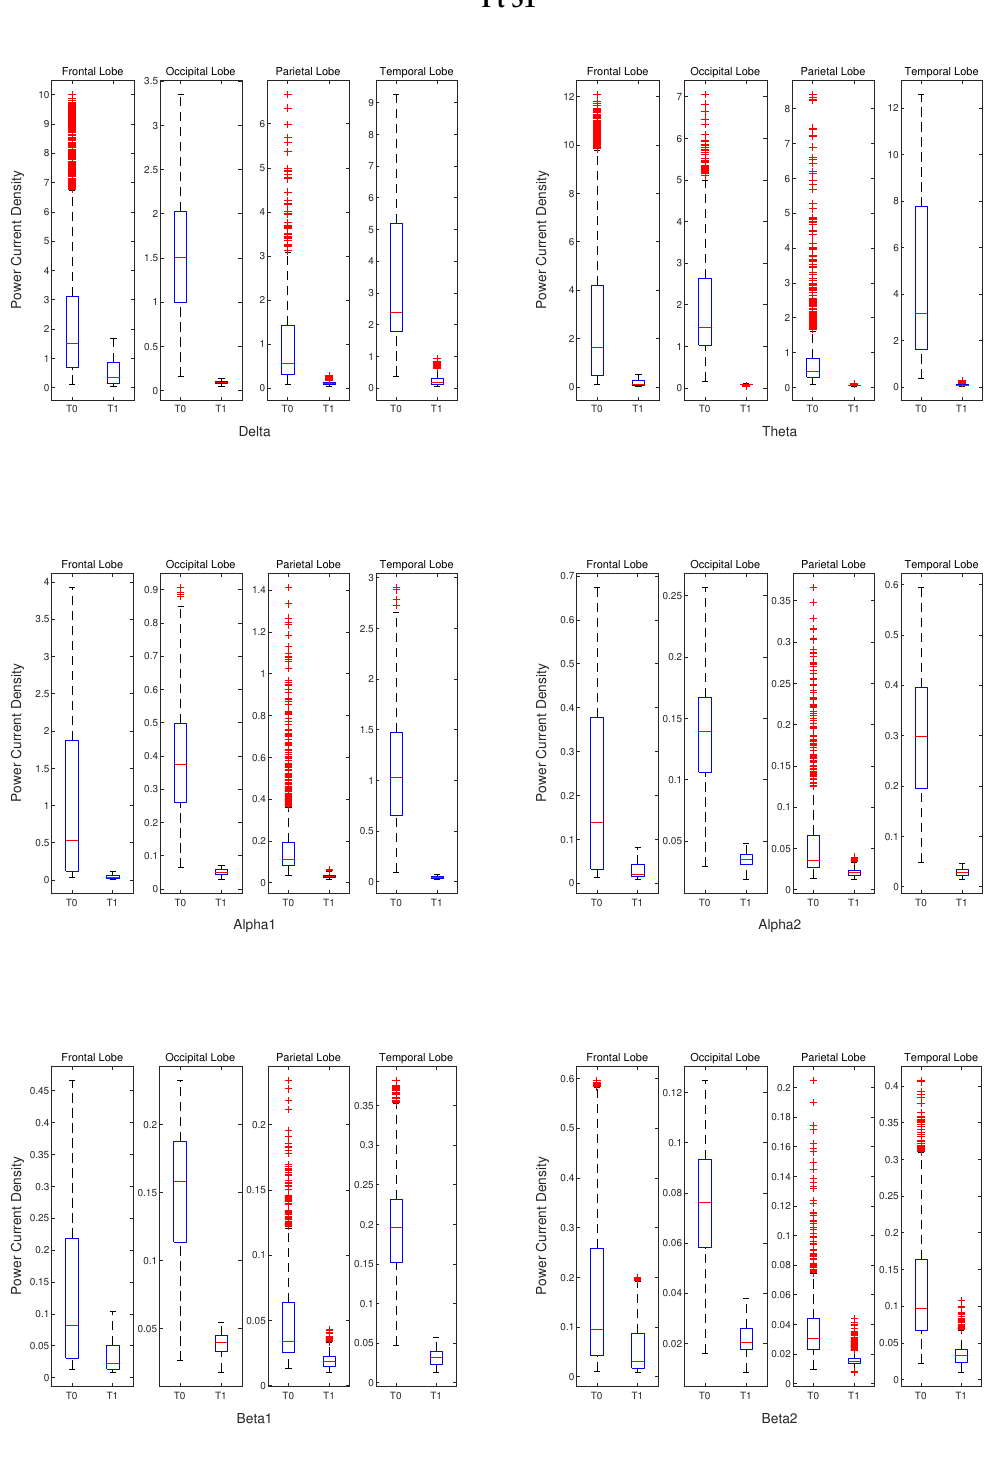
Figure 5. Boxplot of the power current density of patient 51 at time T0 and T1 for each frequency sub-band and each region of interest (frontal, occipital, parietal, and